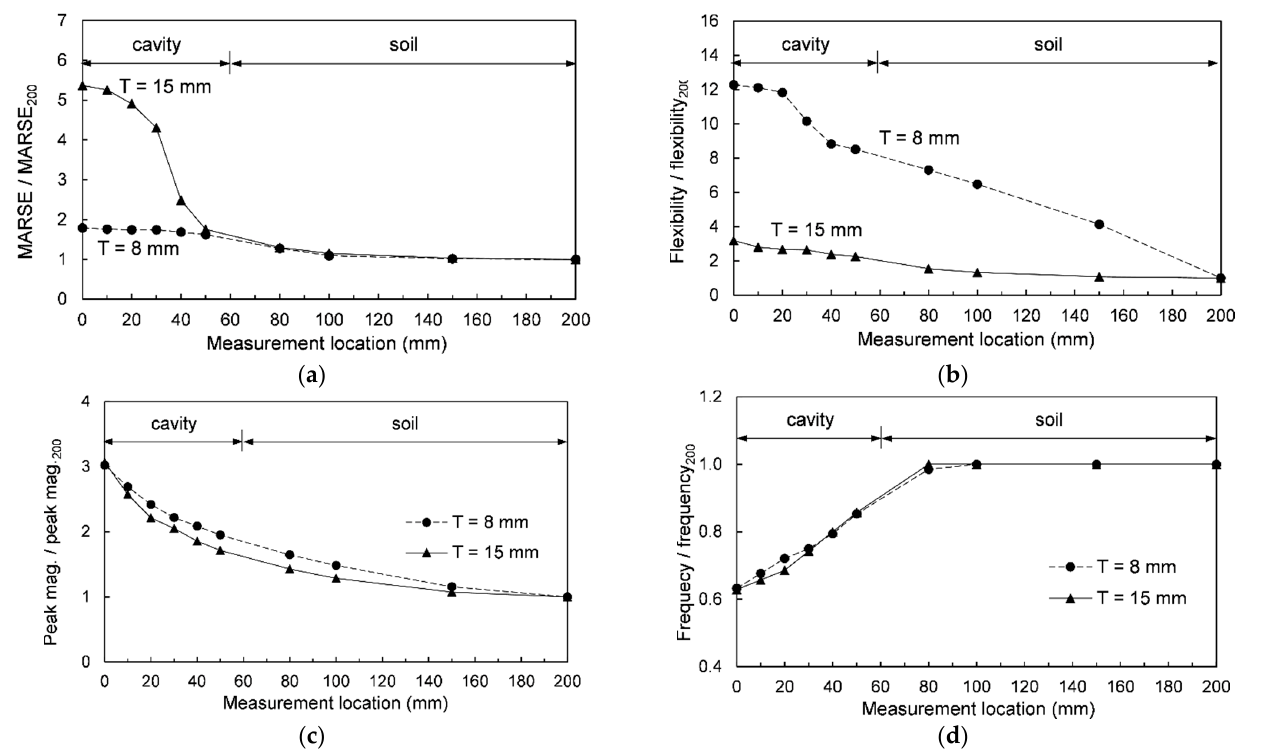
Figure 9. Normalized values according to measurement location: ( a ) MARSE energy; ( b ) flexibility; ( c ) peak magnitude; and ( d ) frequency corresponding to peak magnitude.